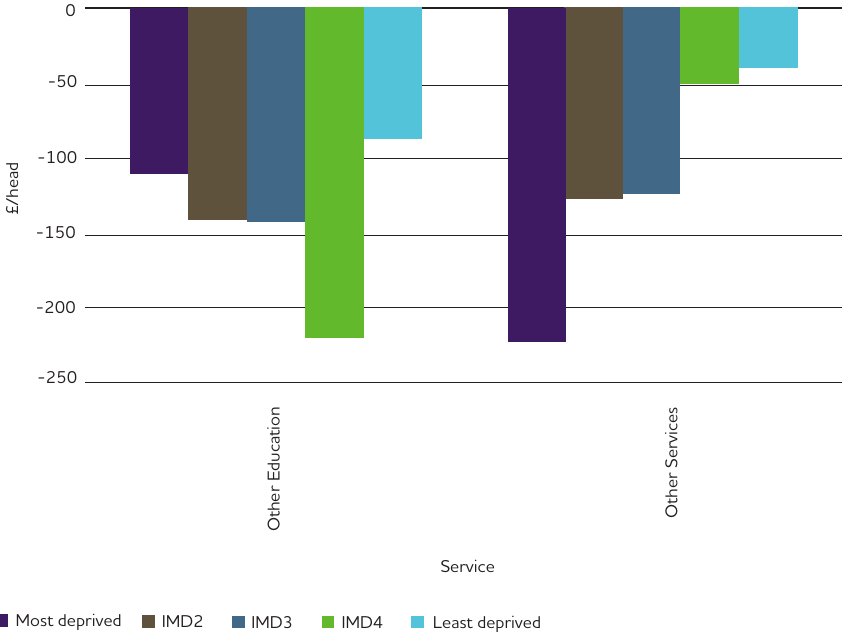
Figure 3: Real Budget Changes by Other Education vs Other Services for English All Purpose Authorities by Deprivation Band, £ /head,